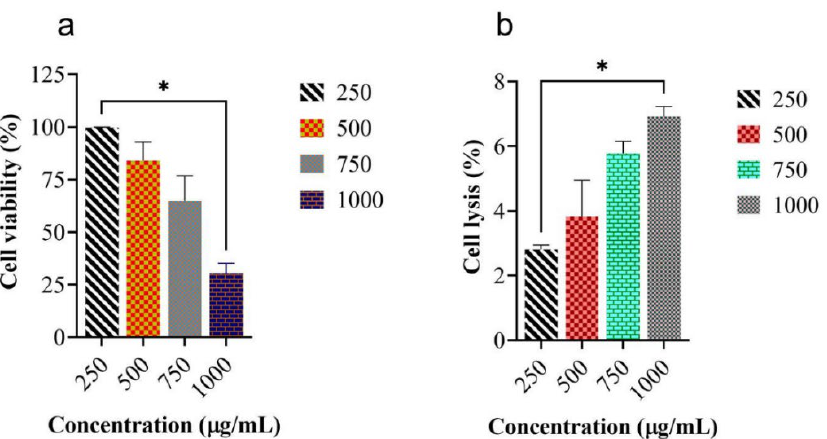
Figure 2. Measurement of cell viability (MTT assay) and hemolytic activity of U. reticulata . ( a ) Cell viability was determined by MTT assay. J774 cells treated with MEUR. Absorbance was measured at 630 nm. Values are mean ± S.D ( n = 3). ( b ) The hemolytic activity of MEUR, Absorbance was measured at 630 nm. Values are means ± S.E.M. ( n = 3). The mean values were analyzed using Dunn’s multiple comparison test. * p < 0.05 considered as significant.